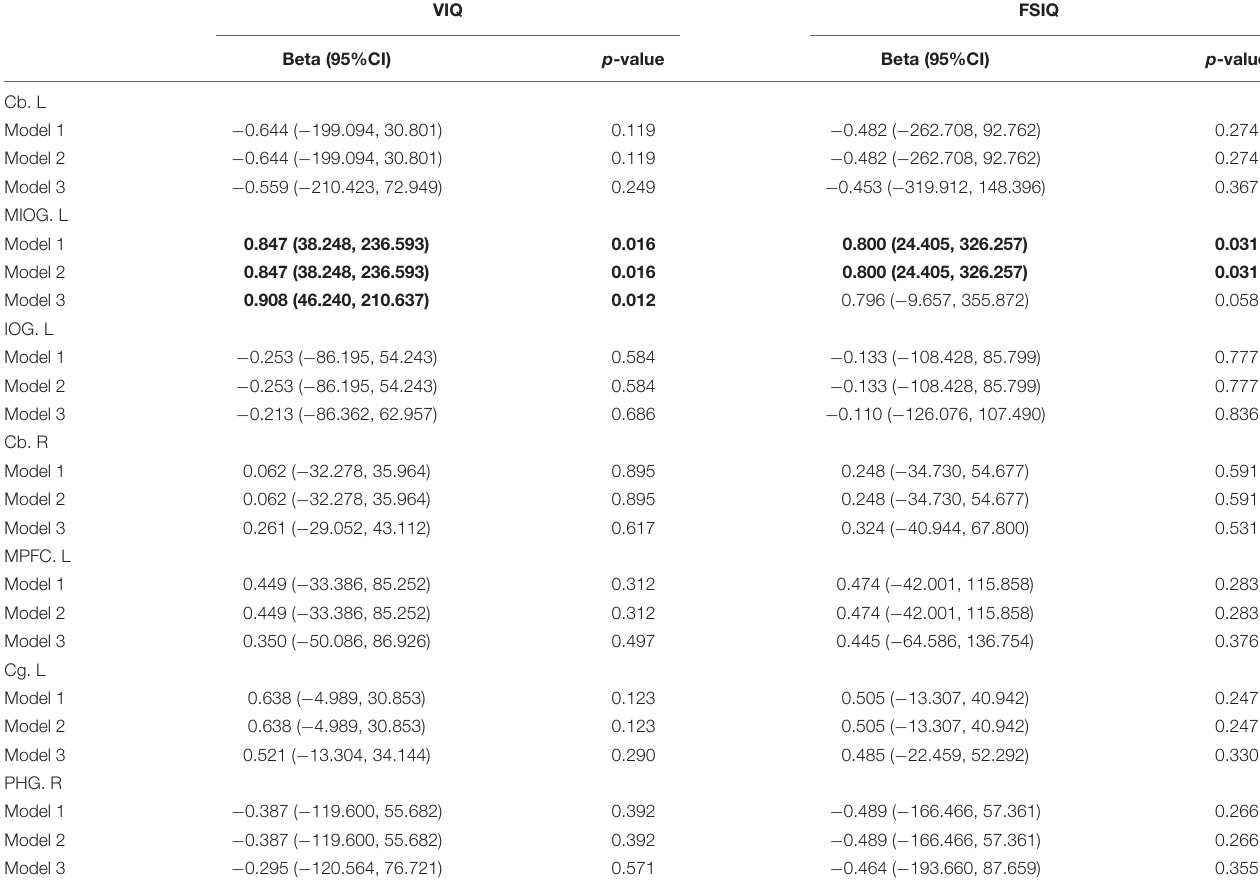
TABLE 4 | Multivariable association of cerebral amplitude of low frequency fluctuations changings and cognitive abilities in TOF postoperative children. VIQ FSIQ Beta (95%CI) p -value Beta (95%CI) p -value Cb. L